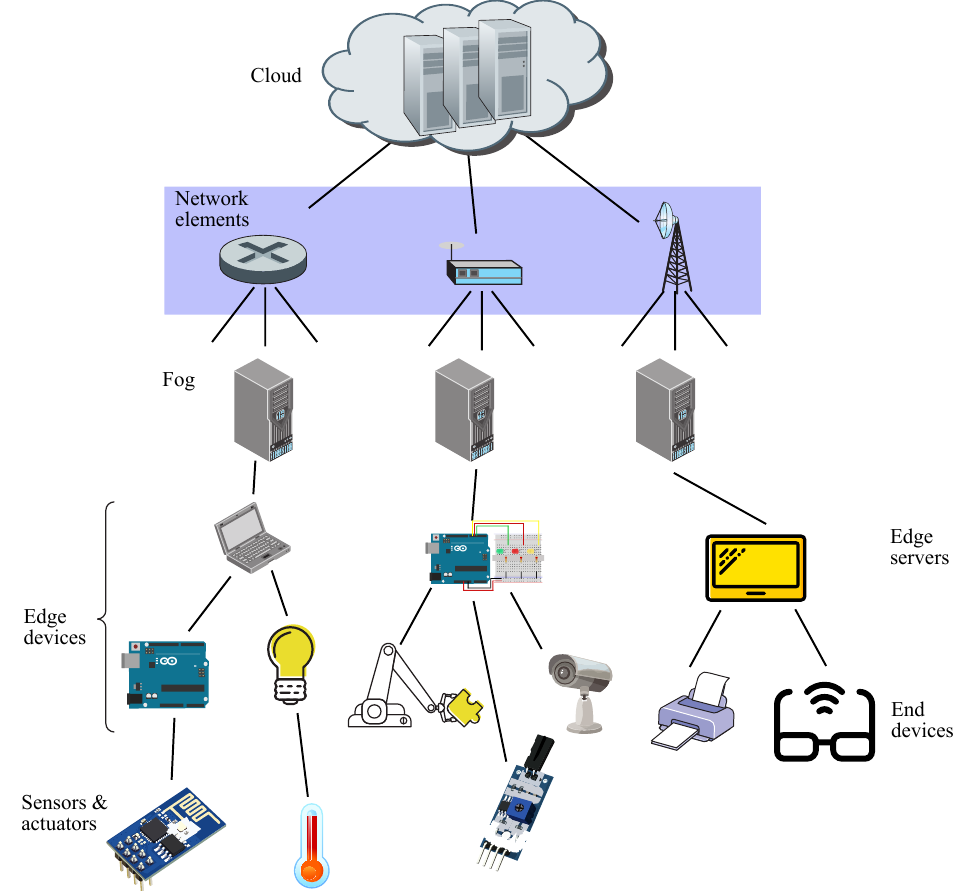
Figure 2. Schematic diagram for fog